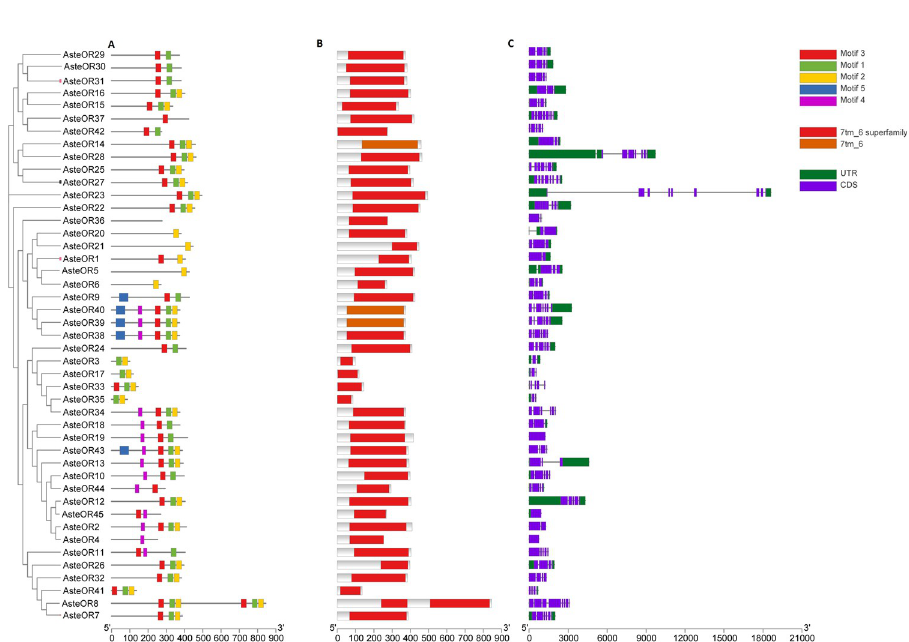
Fig 10. Gene structure of the ORs. Conserved MEME motifs (A), Pfam domains (B) and UTR/CDS (C) are represented in the figure. Structural domain 7tm_6 of the odorant receptors is present in all the ORs. Whereas some sequences lack the conserved motifs due to partial sequence. UTRs/CDS along with intronic regions are also represented.